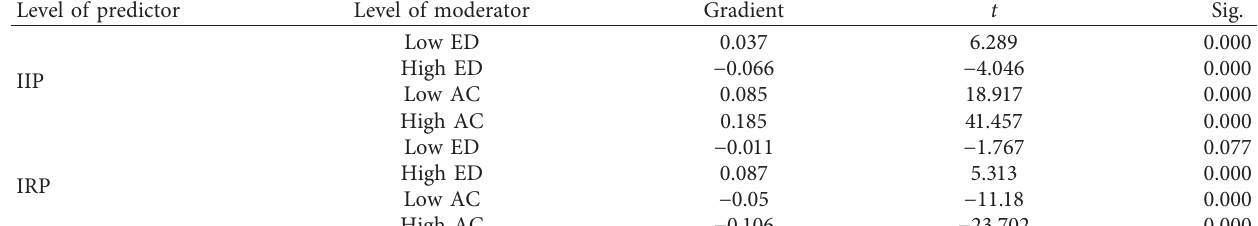
Table 2: Results of testing simple slopes.